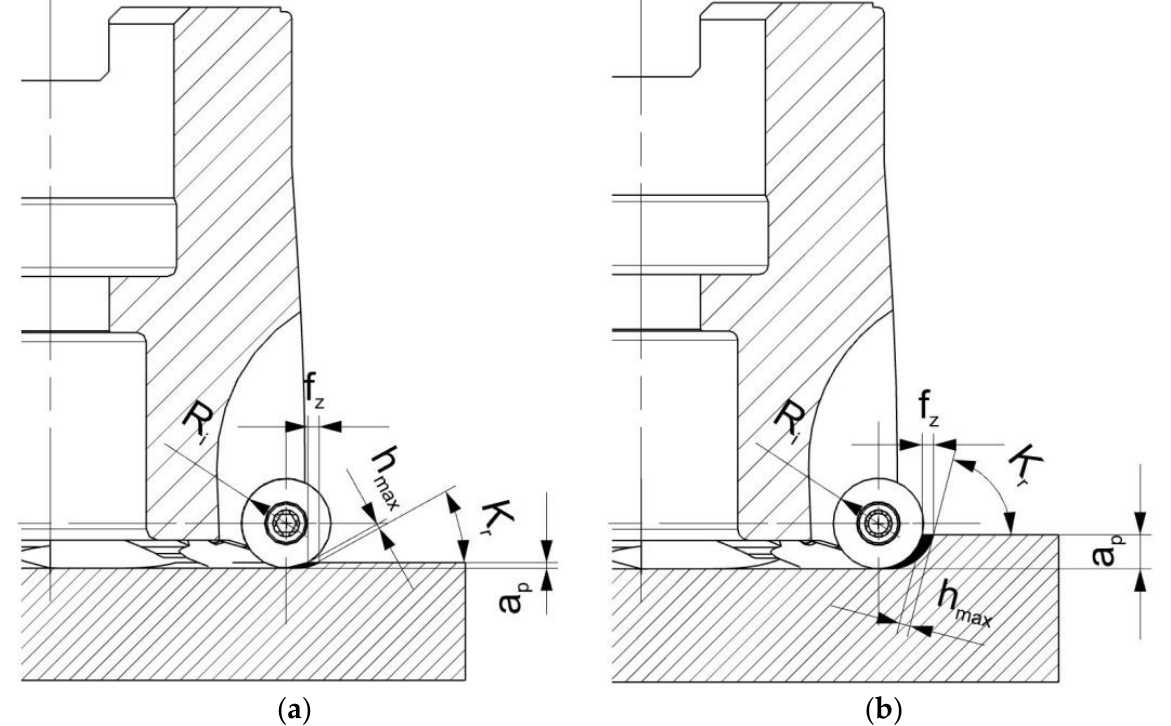
Figure 1. The influence of axial infeed on the entering angle: ( a ) small axial infeed; ( b ) large axial infeed.